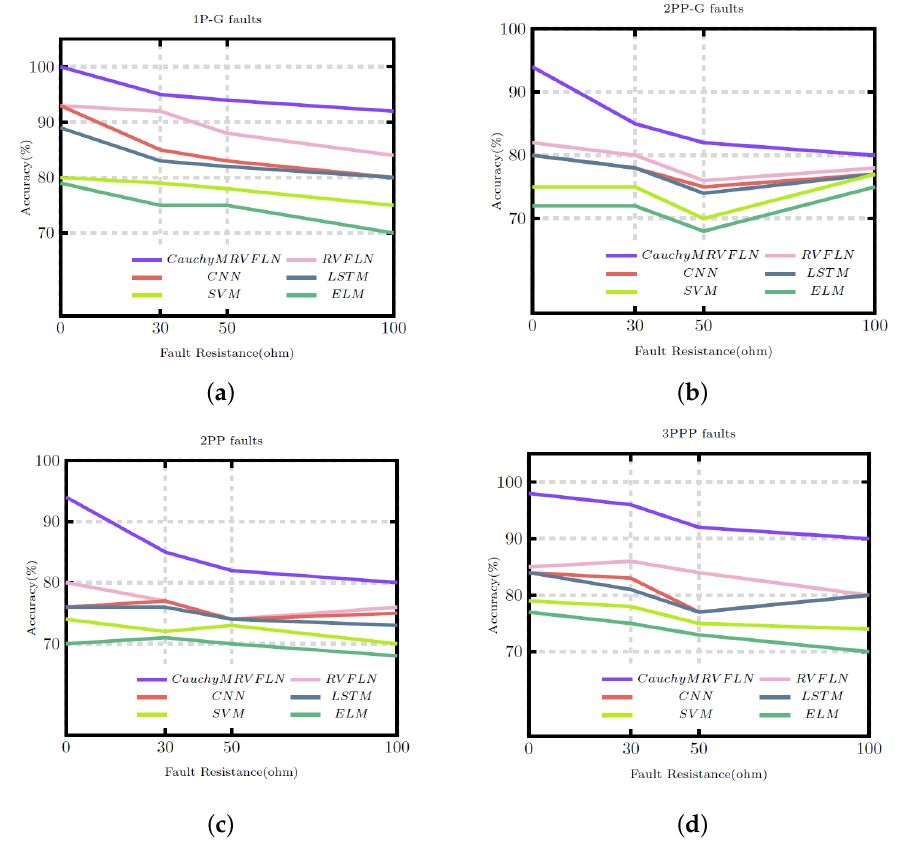
Figure 4. The Fault Detection Accuracy of Different